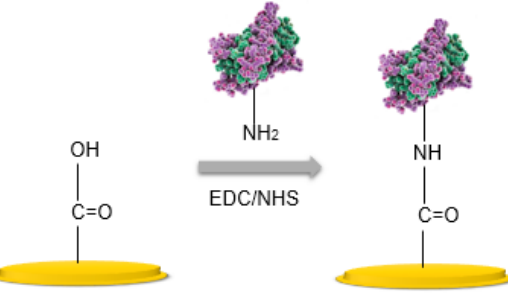
Figure 7: A scheme of covalent attachment of the biomolecules via EDC/NHS surface chemistry.